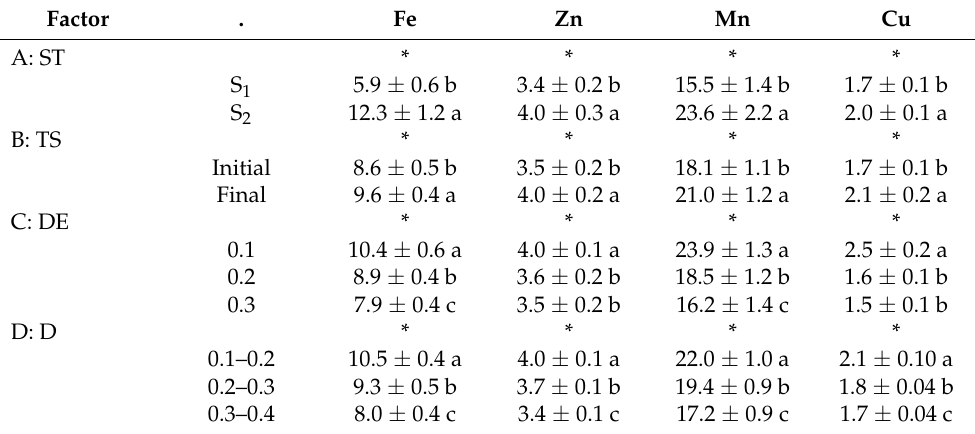
Table 3. Average concentration of Fe, Zn, Cu, and Mn (mg kg − 1 ) in soil profile and the interaction between the different factors. Soil type (ST), time sampling (TS), distance of the sample from the emitter (DE), and depth